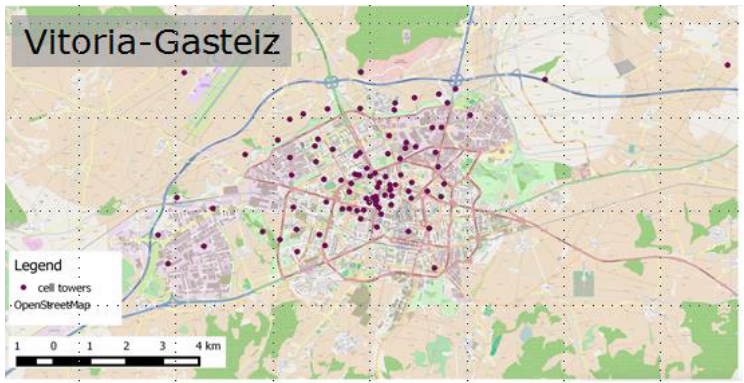
Figure 14. Coarse density of mobile phone cell tower locations in Vitoria-Gasteiz.